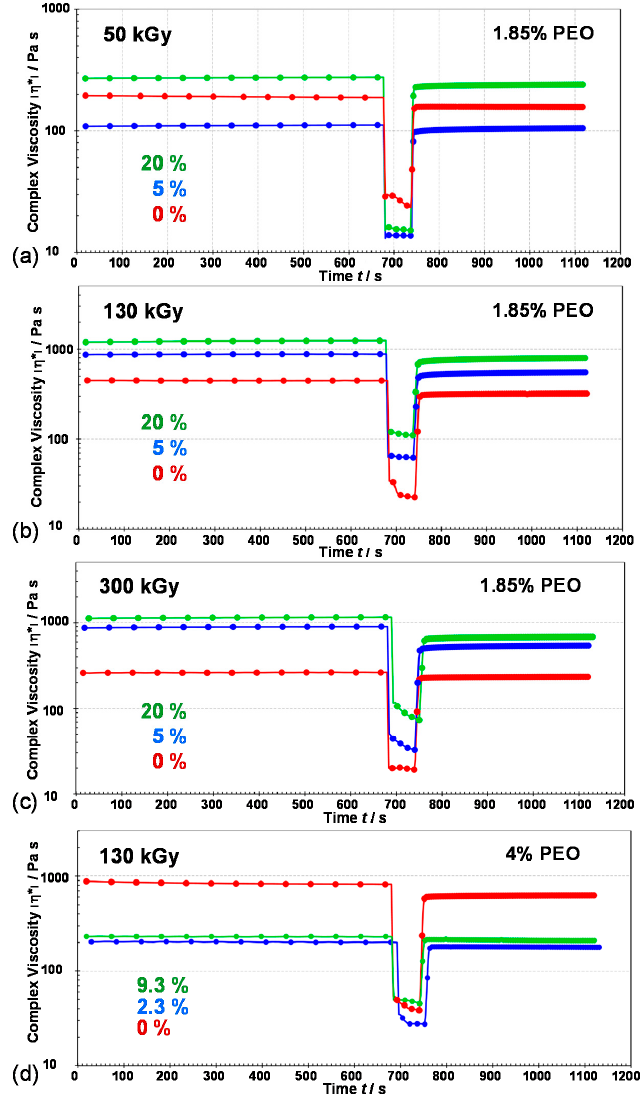
Figure 14. 3-interval thixotropy test (3ITT) of pure PEO gel and nanocomposite gels obtained at ( a ) 50 kGy, ( b ) 130 kGy, ( c ) 300 kGy from 1.85 wt% PEO suspensions and ( d ) from 4 wt% PEO suspensions at 130 kGy showed complex viscosity ( ղ *) as a function of time and application of different strains (LVR-DR-LVR) at 25 °C. Linear viscoelastic region (LVR): strain = 0.1%, frequency = 5 Hz; destructive region (DR): strain =300%, frequency = 5 Hz. Initial mass percentage of Fe 3+ in precursor suspensions is indicated.